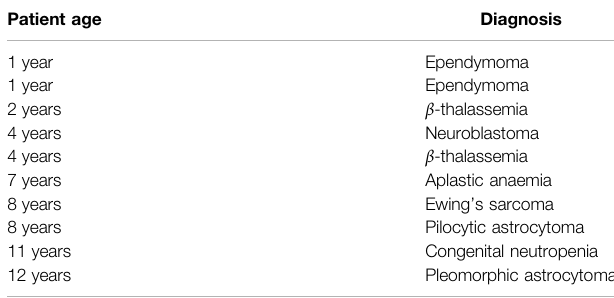
TABLE 1 | Pre-pubertal patient ages and